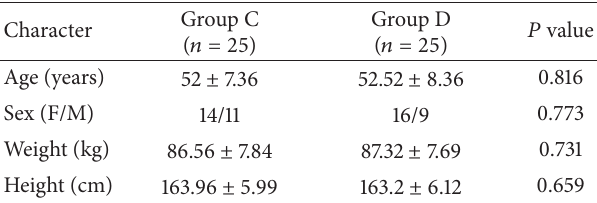
Table 1: Demographic data.